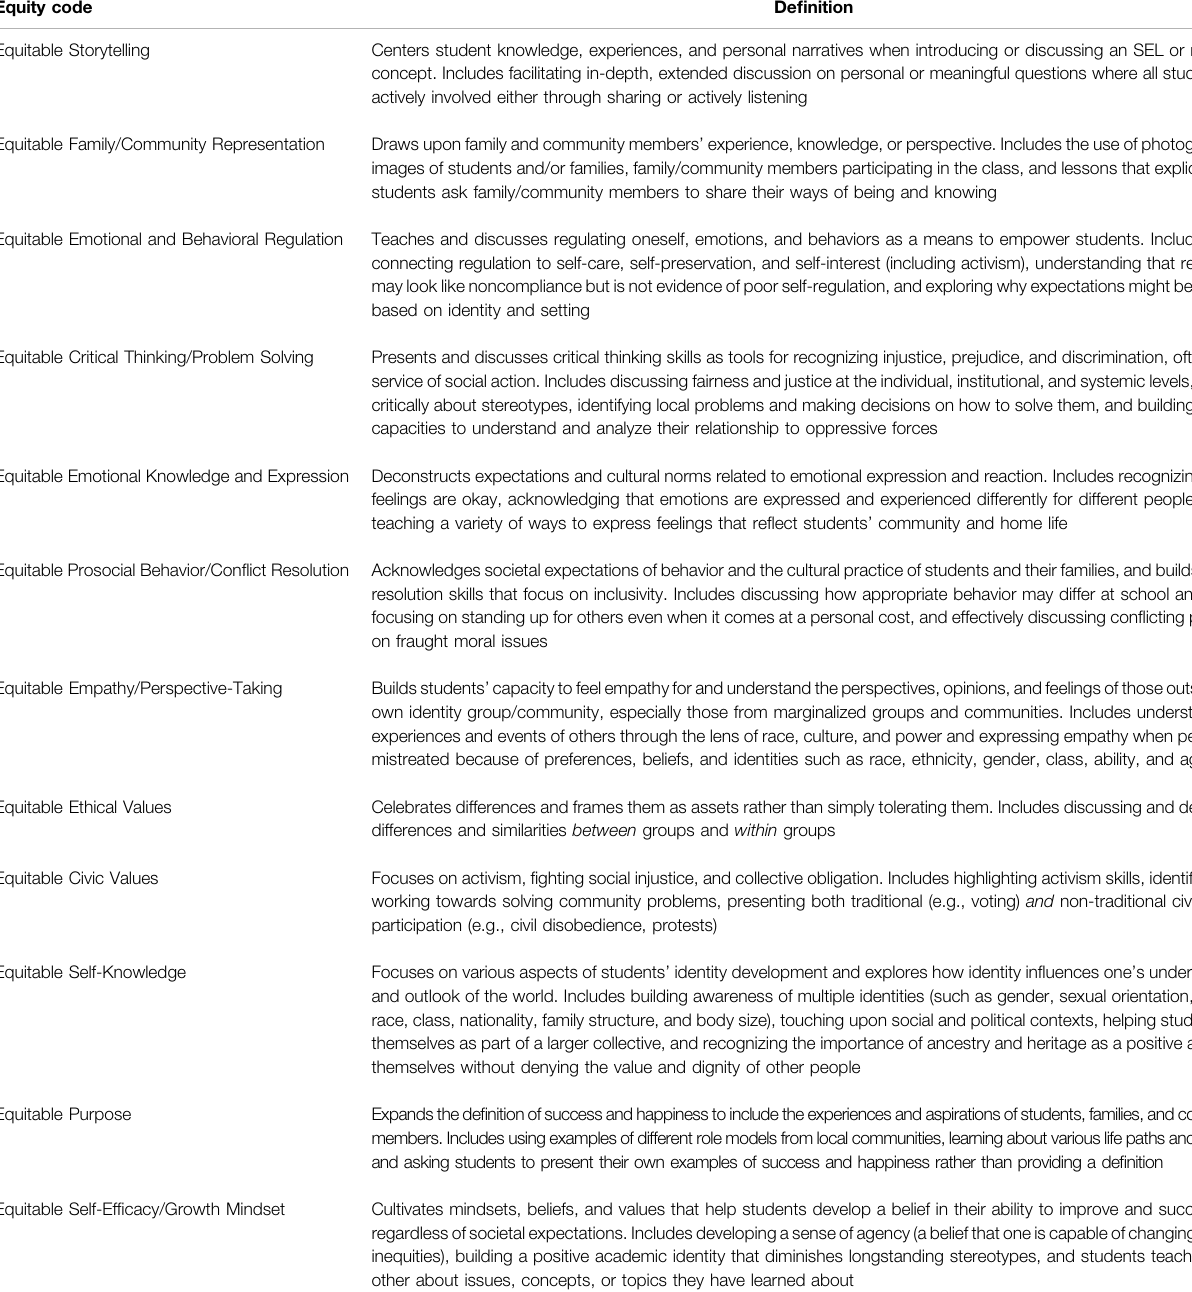
TABLE 1 | Descriptions of equity